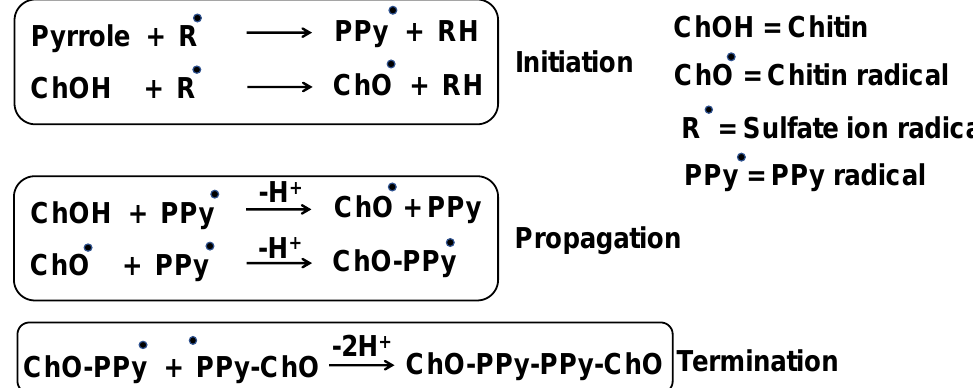
Scheme 3. Proposed mechanism of grafting of PPy onto chitin.